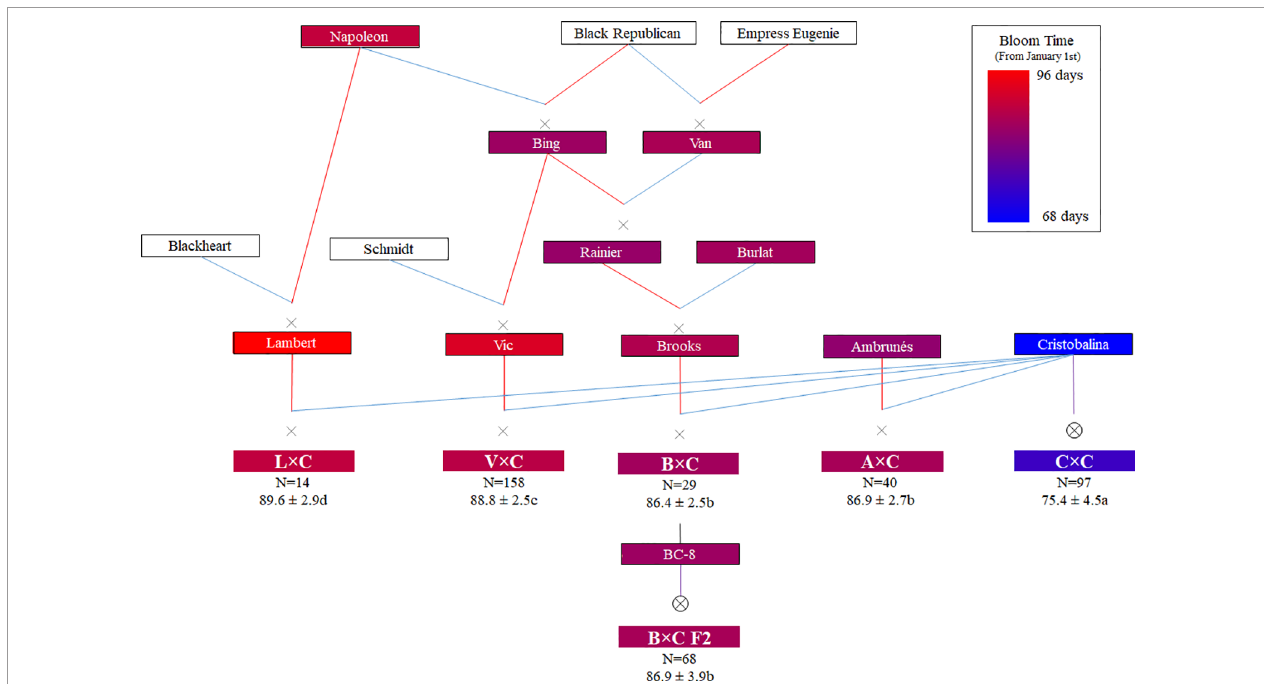
FIGURE 1 | Families, parental and ancestor cultivars used in this work with their known pedigrees (Red and blue lines indicate female and male parent, respectively). Color code (from Pedimap software; Voorrips, 2007) indicates the BLUP (Best linear unbiased prediction) of bloom time values expressed in Julian days (JDs). In the families, the number of individuals (N), mean value of bloom in JDs and signi fi cant differences of bloom time among different families (ANOVA and Tukey Test; P < 0.05) are also